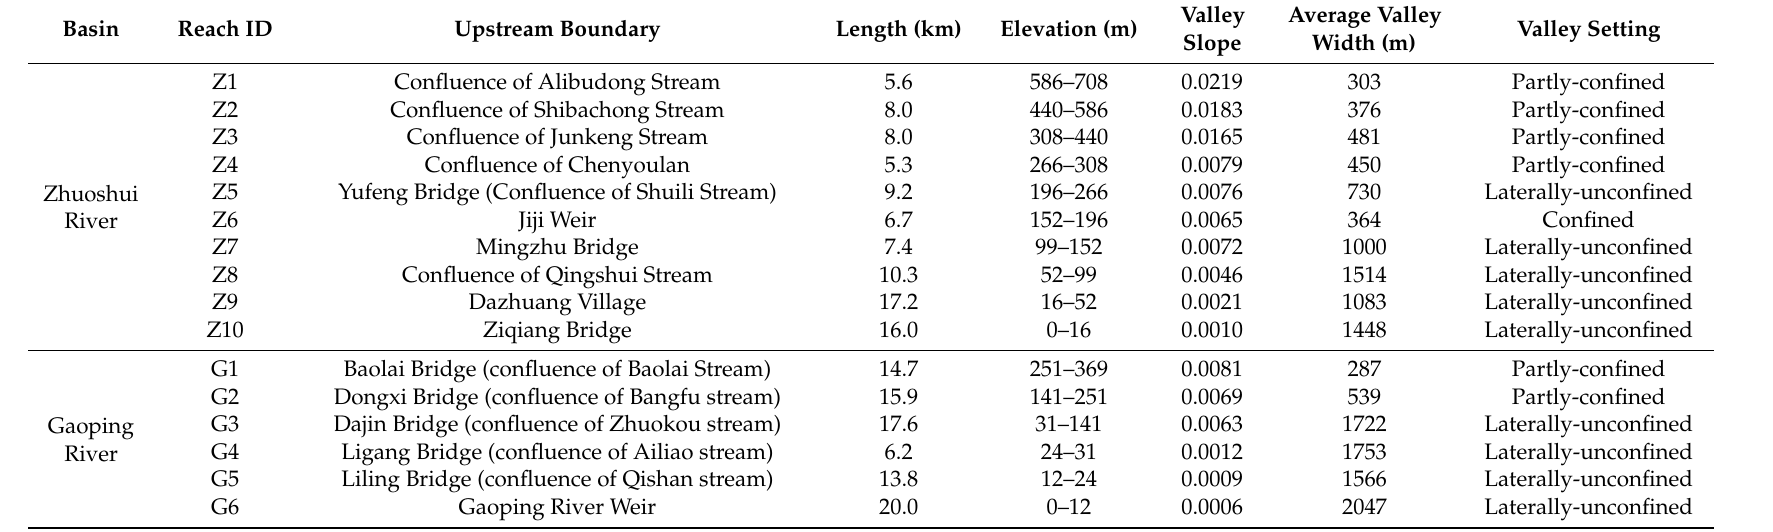
Table 1. Boundaries and attributes of study